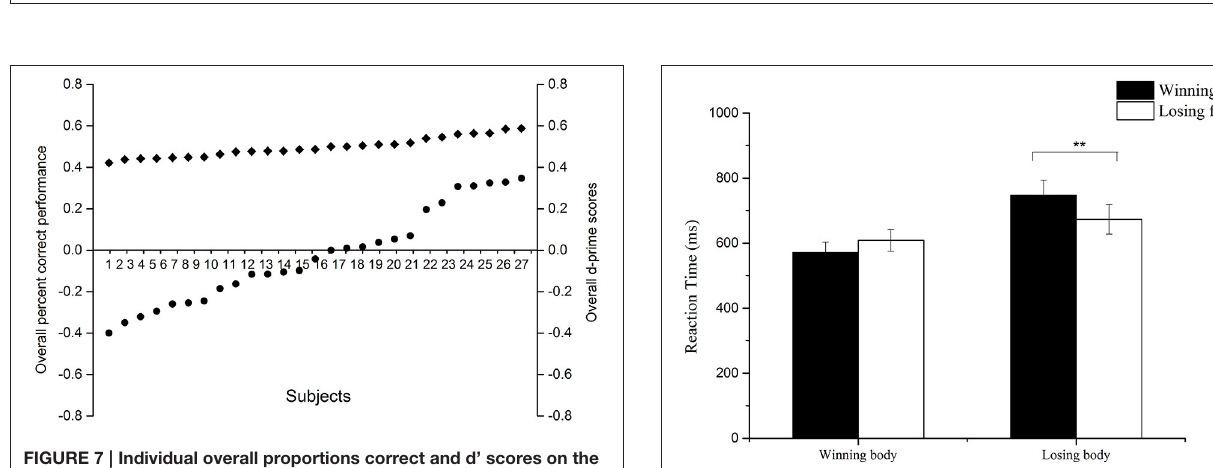
FIGURE 6 | (A) Examples of noise image and image of geometric shape used; (B) Revised procedure of subliminal affective priming task used in Experiment 2B.